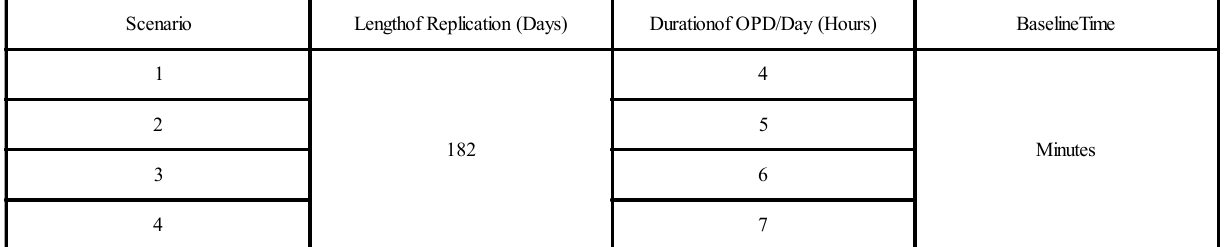
TABLE 8: REPLICATION PARAMETERS SET FOR SCENARIO ANALYSIS